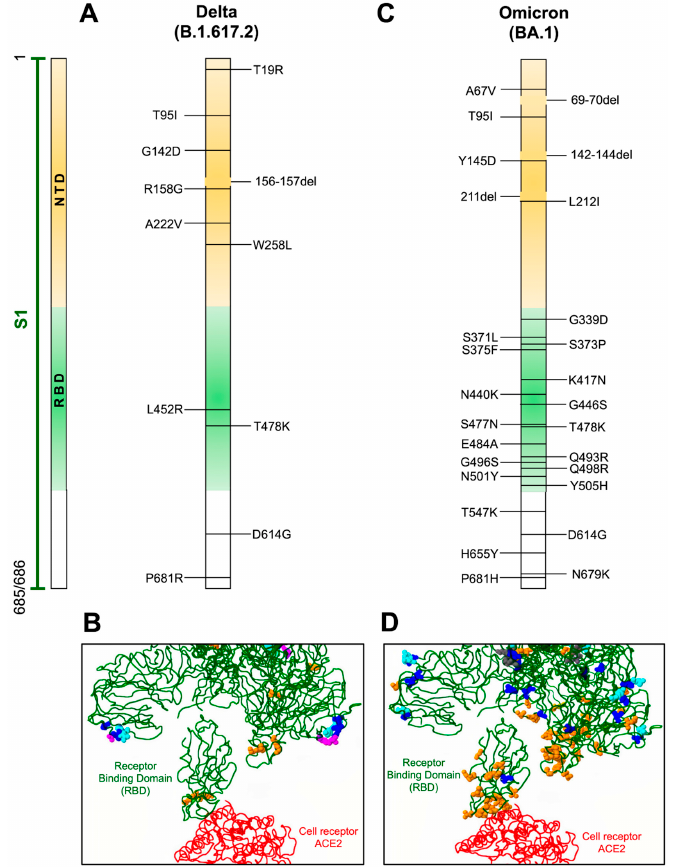
Figure 2. Mutations in Delta and Omicron variants. ( A , C ) Localization of defined mutations in the S1 domain and RBD of the spike protein of Delta and Omicron SARS-CoV-2 variants. ( B , D ) Model of mutations associated with the RBD domain (green) of the spike protein in interaction with the ACE2 receptor (red). Amino acid changes occurring more than one hundred times are indicated in blue, amino acids involved in direct interaction with ACE2 or associated with antigenicity are displayed in orange, potential amino acids involved in glycosylation are depicted in magenta, and amino acids inserted or deleted are indicated in cyan. GenBank access for the Delta variant is QWK65230.1 and for Omicron is OM095411.1. Modeling of the RBD domain with ACE2 was evaluated with the CoVsurver mutations app available on GISAID web page